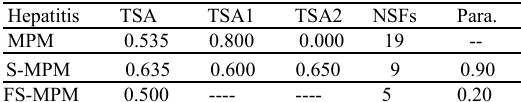
Table 3 TSAs and NSFs for Hepatitis.